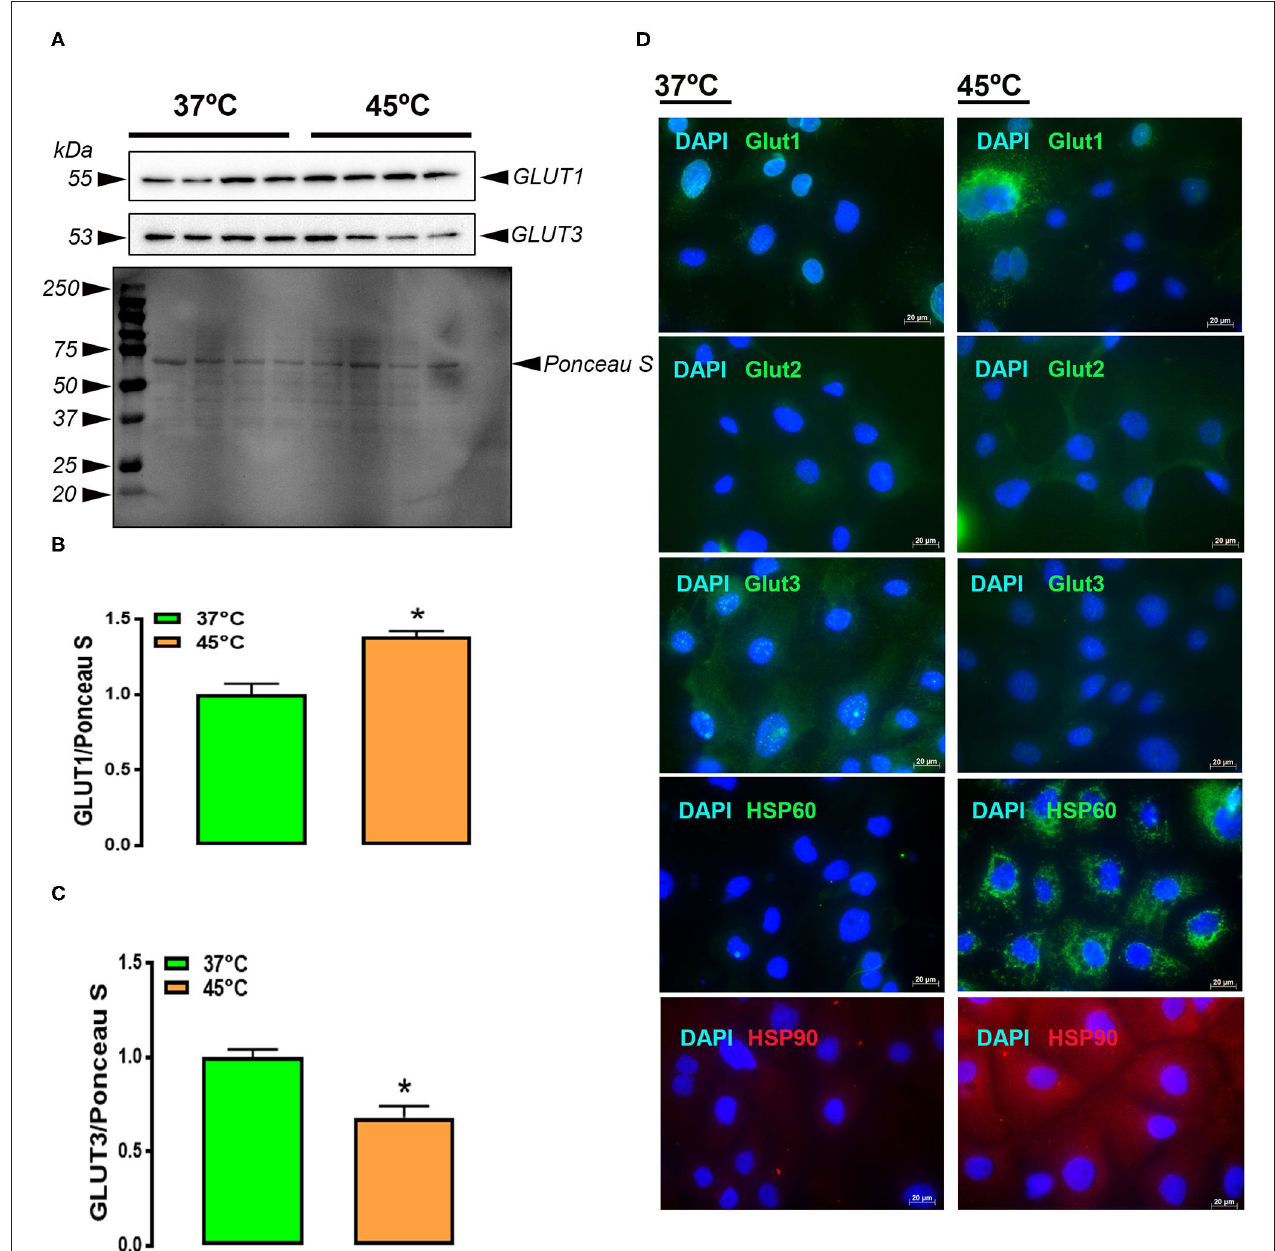
FIGURE 5 | Effect of HS on glucose transporter protein expression in IPEC-J2 cell line. Protein was extracted from cells exposed to HS (45 ◦ C) or 37 ◦ C (control) and analyzed by western blot (A–C) and immunofluorescence (D) . Protein expression was normalized to loading via Ponceau stain (PS) (A) . Protein was analyzed via AlphaView software and is expressed as mean ± SEM ( n = 4/group) with one blot shown (A) . * P < 0.05. GLUT, glucose transporter; HS, heat stress; TN, thermoneutral; DAPI: